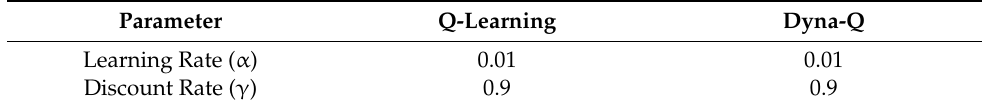
Table 1. Parameter values for experiment.